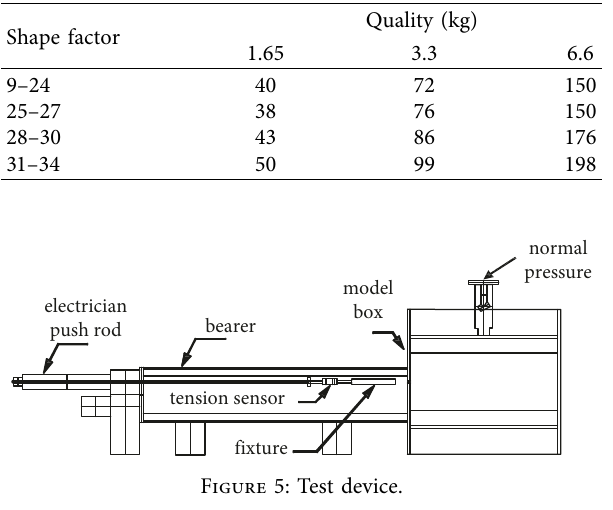
Table 1: Comparison of the number of stones of the same quality.